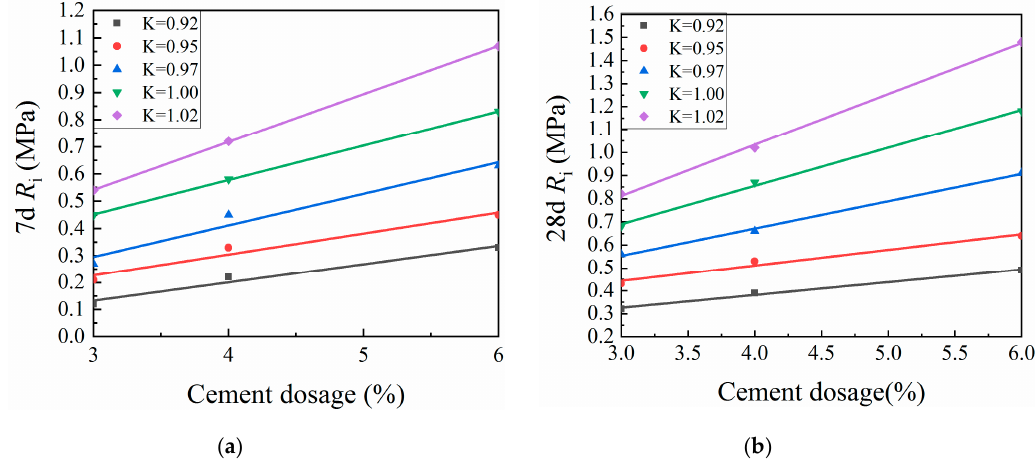
Figure 7. Relationship between cement dosage and splitting strength (SS) of cement-modified loess (CML): ( a ) seven-day (7d) SS; and ( b ) twenty-eight-day (28d)